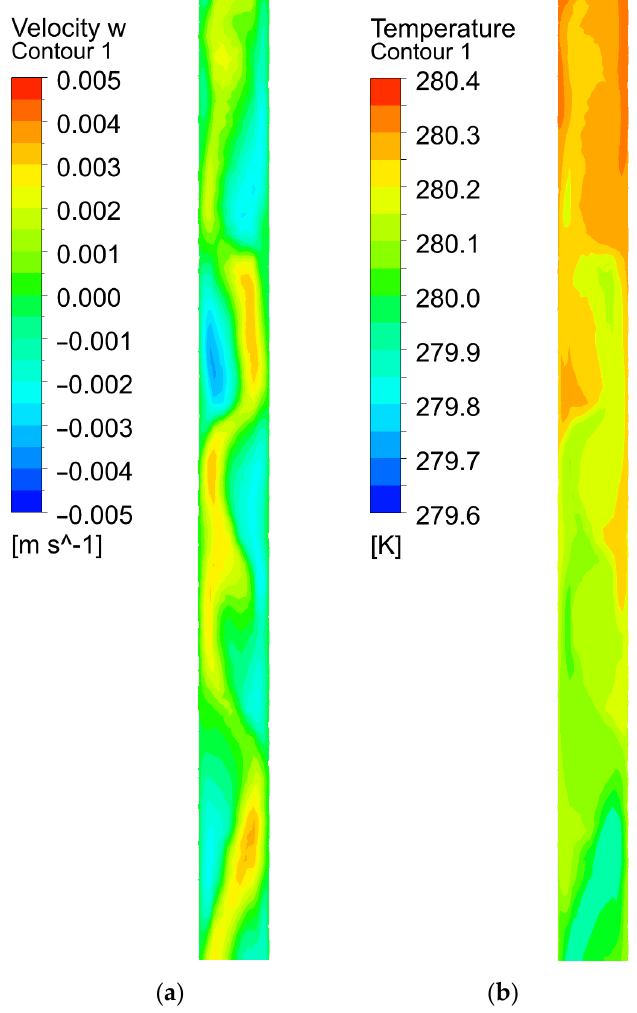
Figure 8. Calculated distributions of the vertical component of the velocity vector ( a ) and temperature ( b ) in a small section of the well.